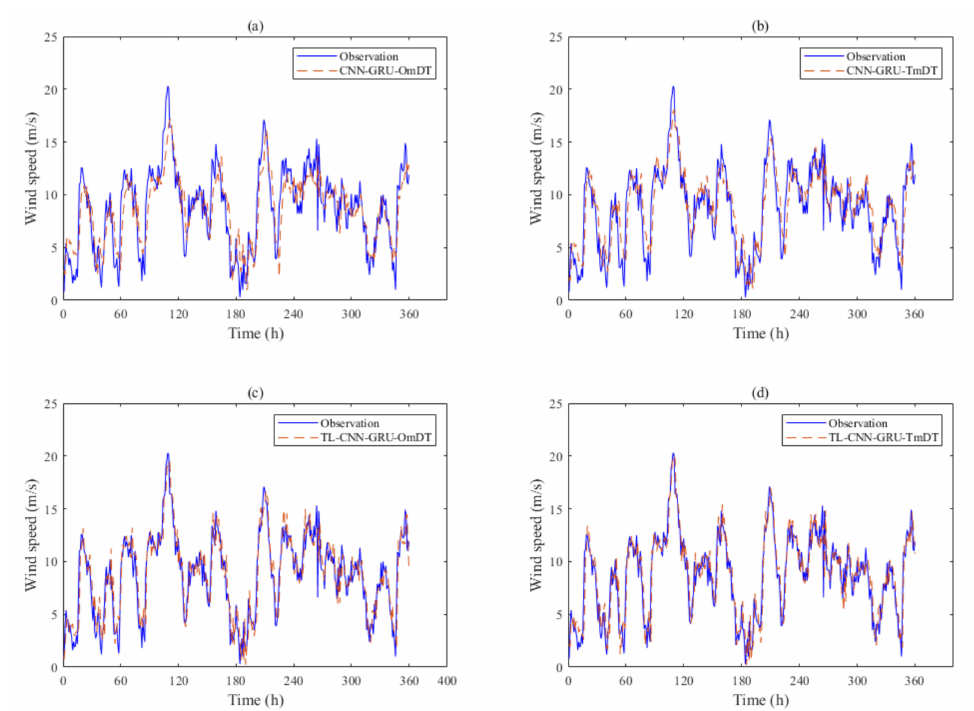
Figure 7. Comparison of different model predicted value and the real value: ( a ) CNN—GRU—OmDT;